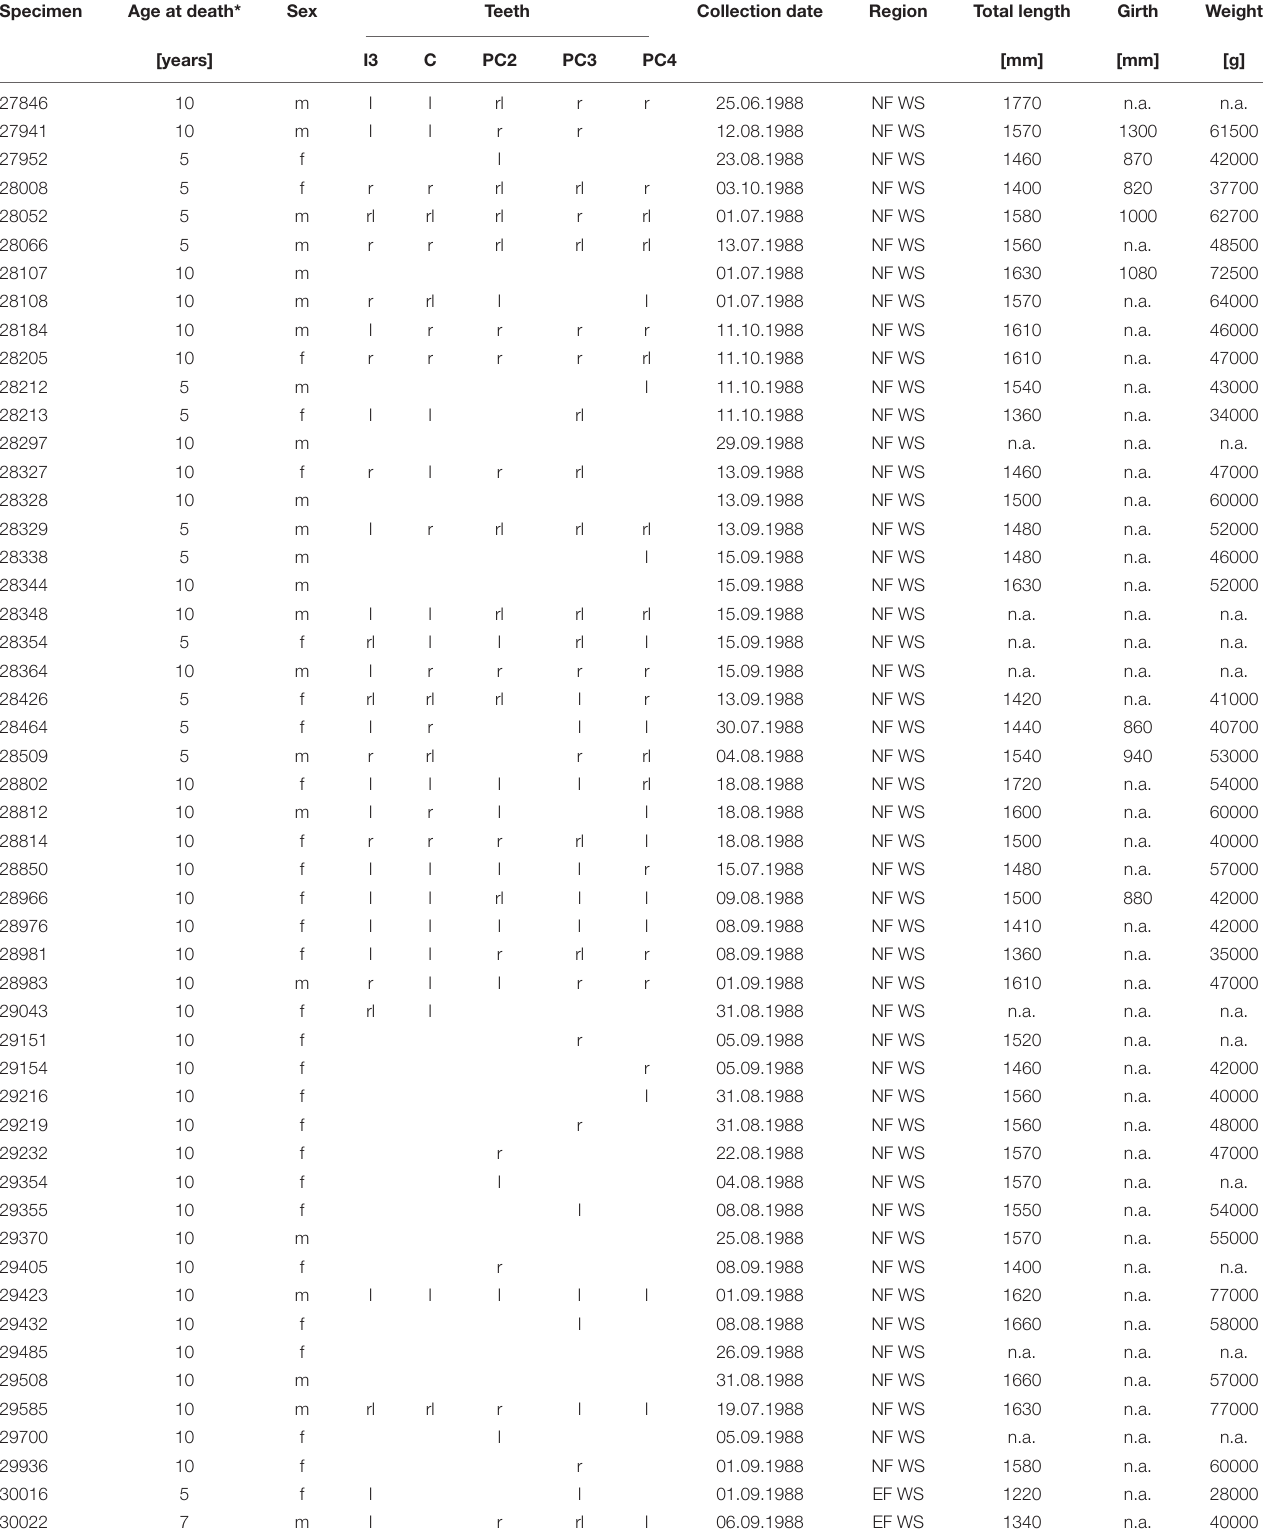
TABLE 1 | Specimens included in the